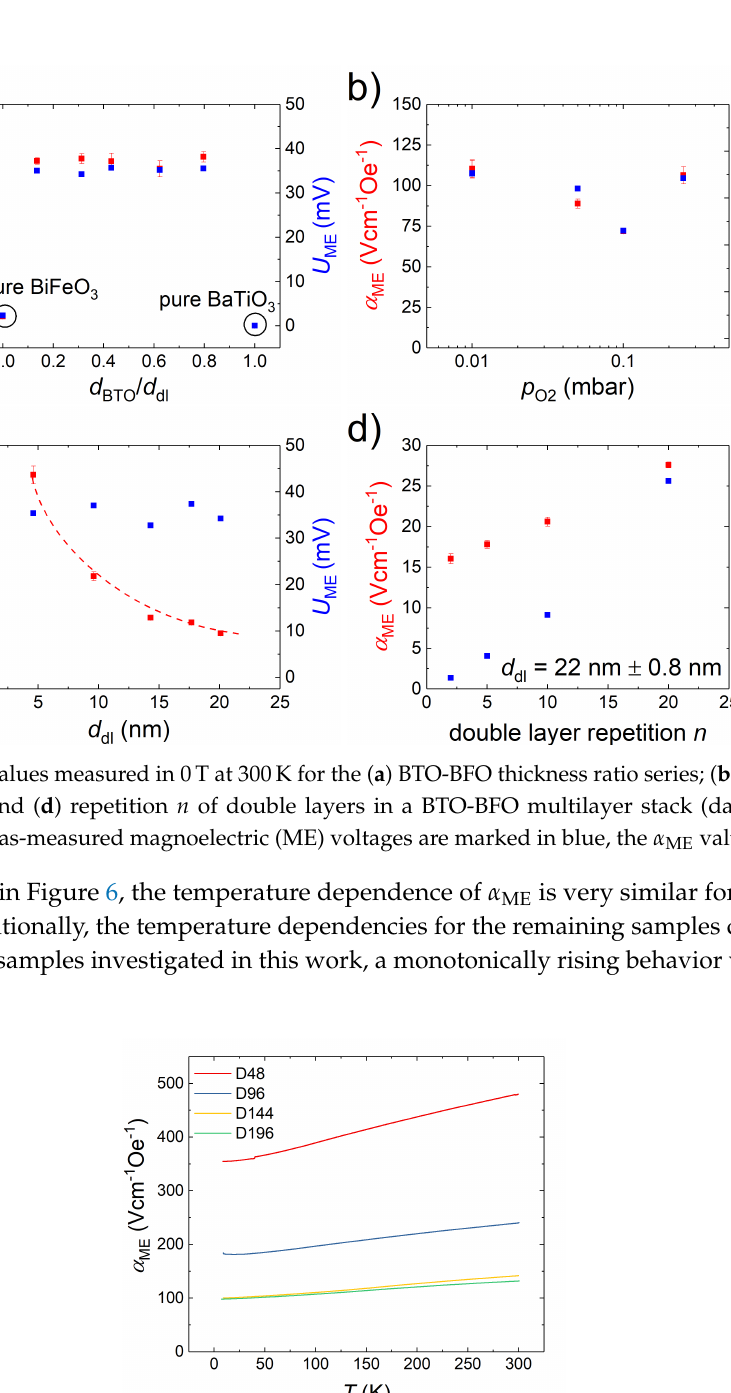
Figure 6. Temperature dependence of α ME measured in 0T bias field for the samples of the d dl